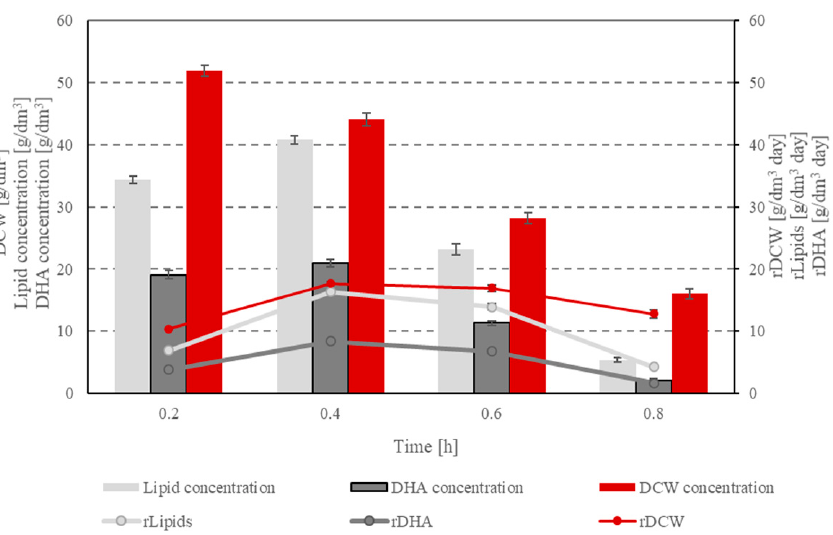
Figure 3. Changes in DCW concentration, lipid concentration, and DHA concentration in Schizochytrium sp. biomass and changes in glycerol concentration in the culture medium during the continuous culture. Table 4. Parameters indicating the efficiency of the continuous culture depending on the dilution rate D (1/day).